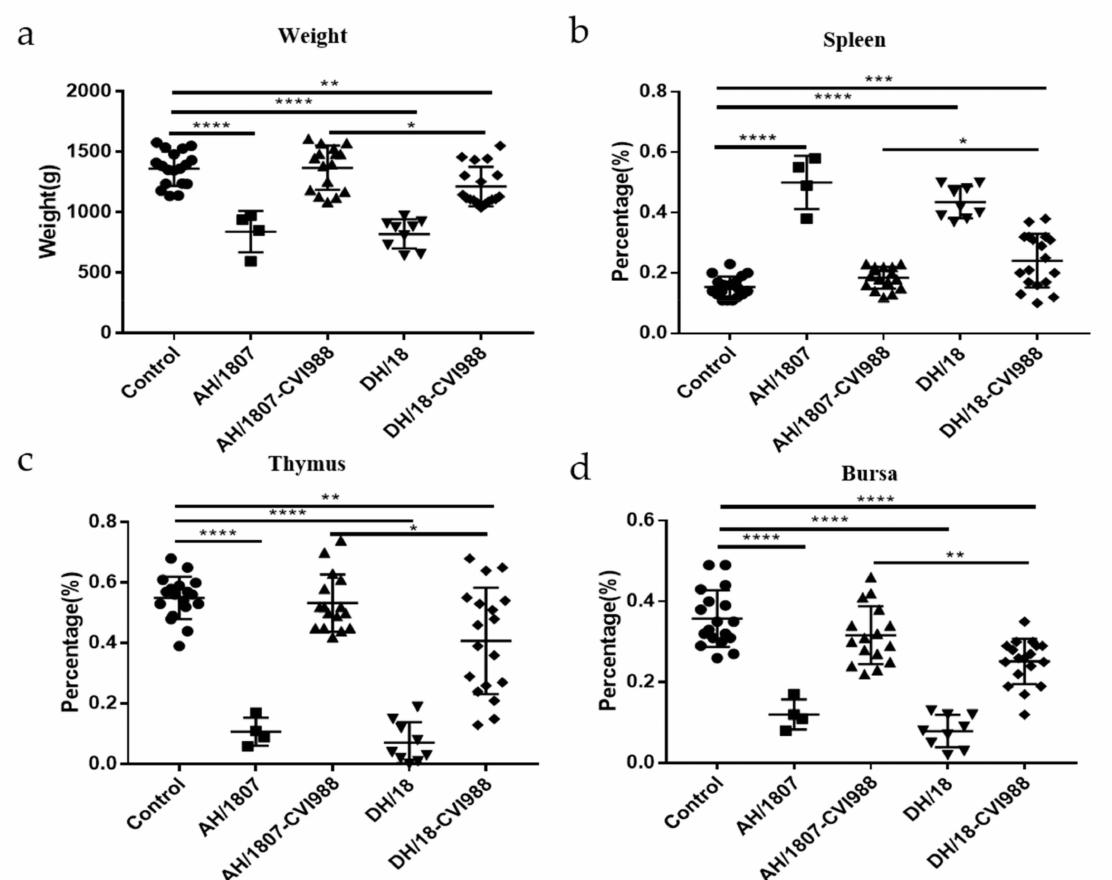
Figure 5. Body weight and ratio of immune organ weight to body weight in control and challenged groups at 72-days post challenge. ( a ) Body weight. ( b ) Ratio of spleen weight to body weight. ( c ) Ratio of thymus weight to body weight. ( d ) Ratio of bursa weight to body weight. T tests were performed for significance analysis. The data are shown as means with standard deviations (SDs). * p < 0.05, ** p < 0.01, *** p < 0.001, **** p <